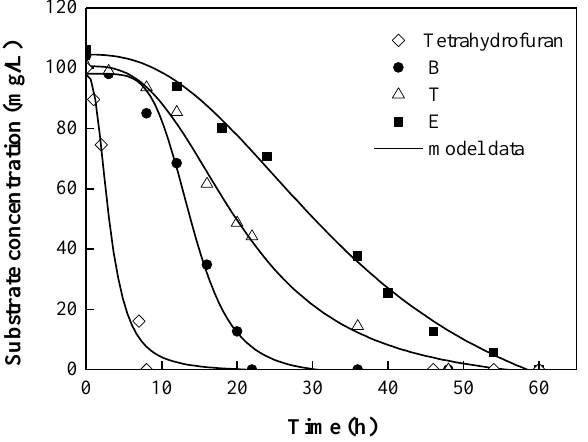
Figure 4. The simultaneous degradation of tetrahydrofuran, benzene (B), toluene (T), and ethylbenzene (E) in quaternary substrate experiment (shapes) and model (lines). The initial culture density in each bottle was 32.2